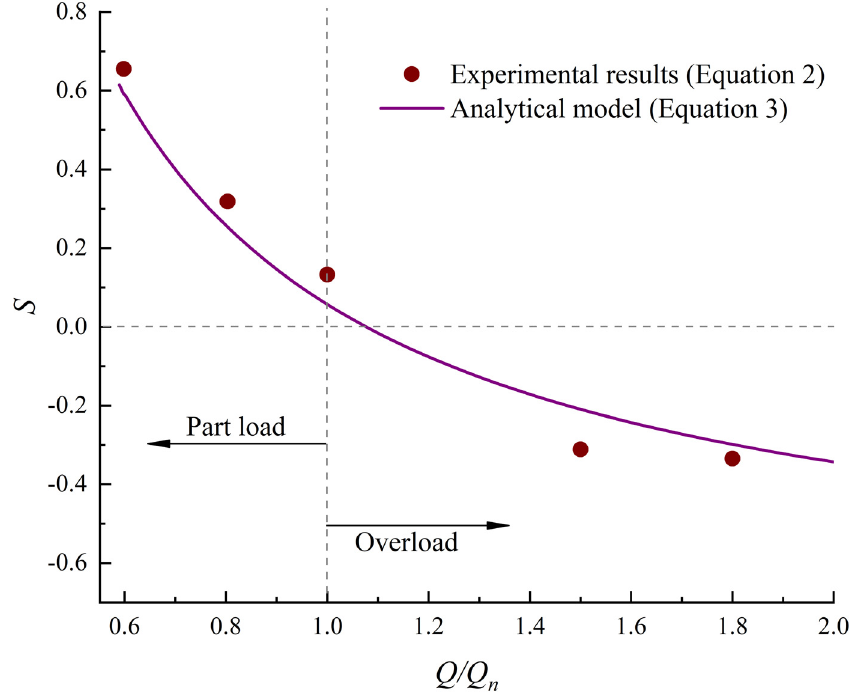
Figure 10. Flow swirl number: comparison of experimental data, Formula (2), and the calculation based on the analytical dependence (3) at z/ D = 1.30.